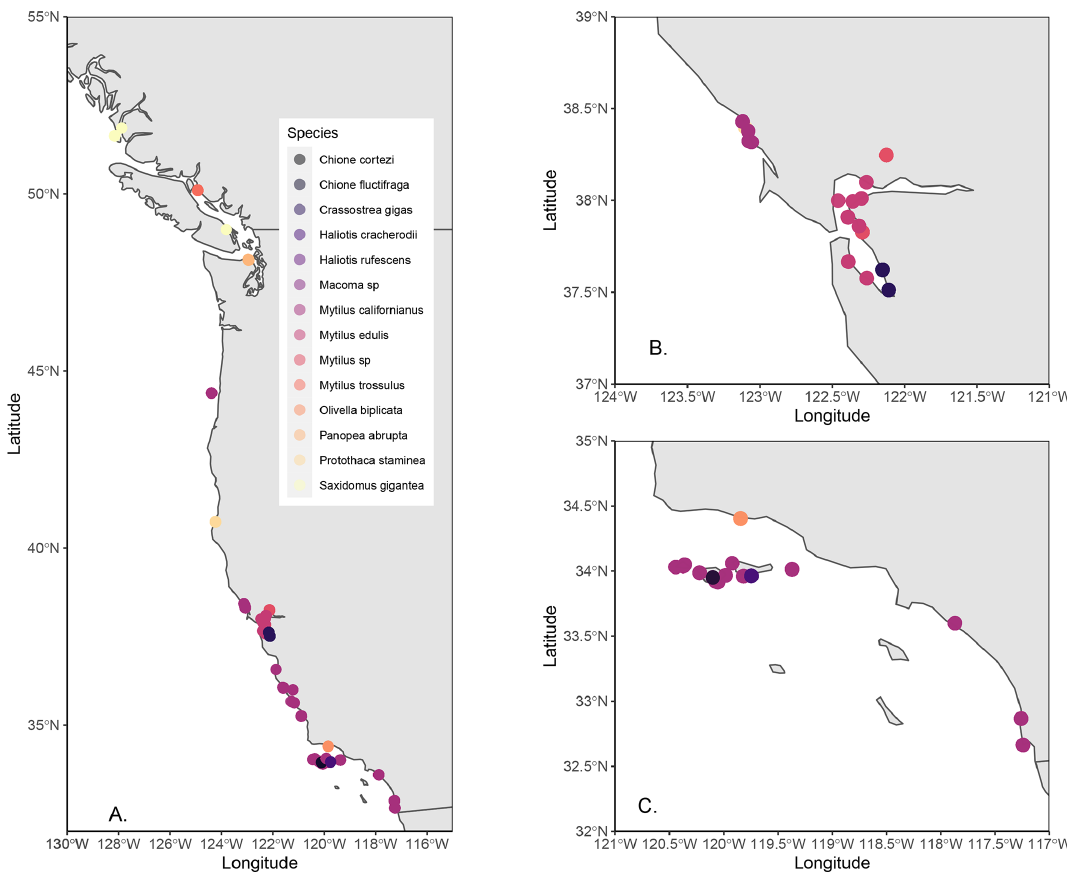
Figure 1. Maps of location of collection (for modern) and midden sites (for midden) of all specimens included in the database. All specimens included in map (a) , zoom-in on northern California (b) , and southern California (c)